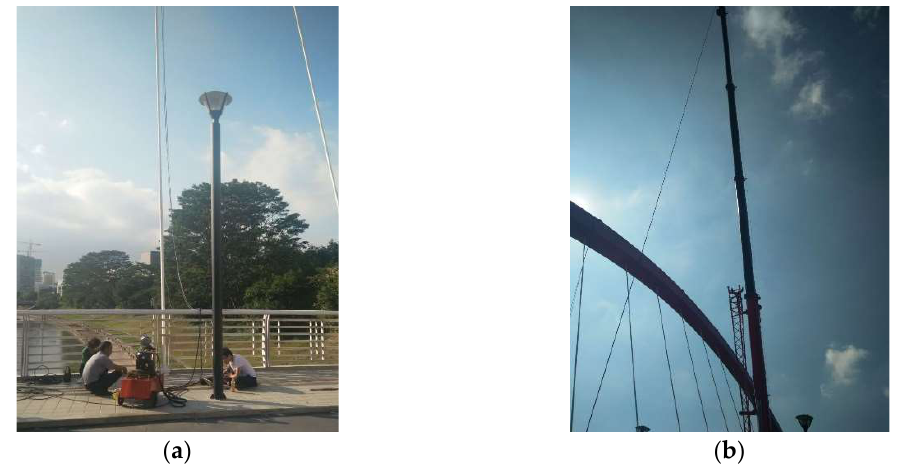
Figure 17. The adjustment of cable forces (cable 8 and 10): ( a ) before the 120th day (9 November 2017); ( b ) after the 120th day (9 November 2017).